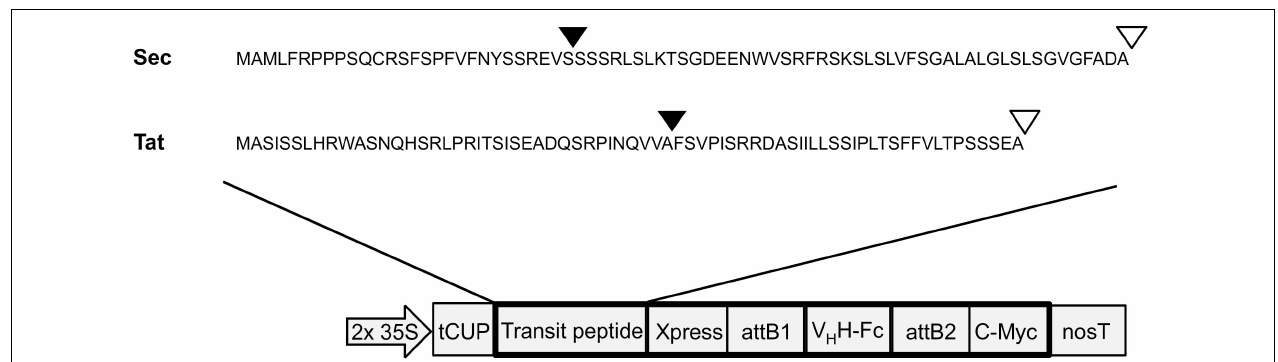
FIGURE 1 | Construction of thylakoid expression vectors. Transit peptide sequences used for thylakoid targeting via either Sec or Tat pathways. Triangles indicate predicted cleavage sites after entry into stromal (black triangles) and thylakoid (white triangles) compartments. 2 × 35S: double-enhanced promoter from Cauliflower Mosaic Virus 35S gene; tCUP, translational enhancer from a tobacco cryptic upstream promoter; attB1/attB2, cloning sites used for Gateway cloning; nosT, nopaline synthase transcription terminator; and Xpress/c-myc, detection/purification